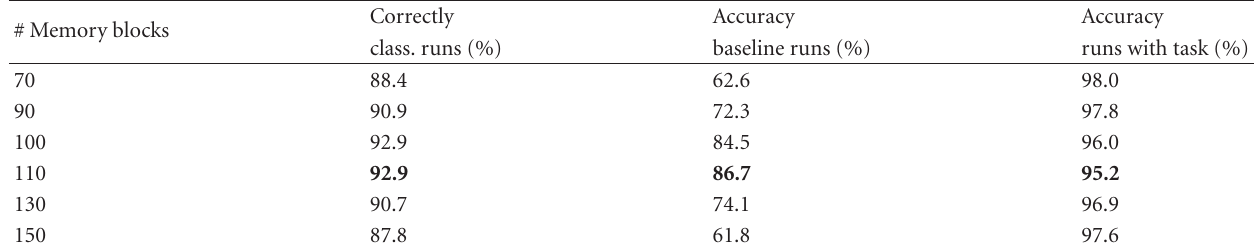
Table 5: Classification of driver distraction (attentive vs. distracted) for complete runs using LSTM networks: correctly classified runs, baseline runs correctly classified as “attentive”, runs with task correctly classified as “distracted” (in percent) for di ff erent numbers of memory